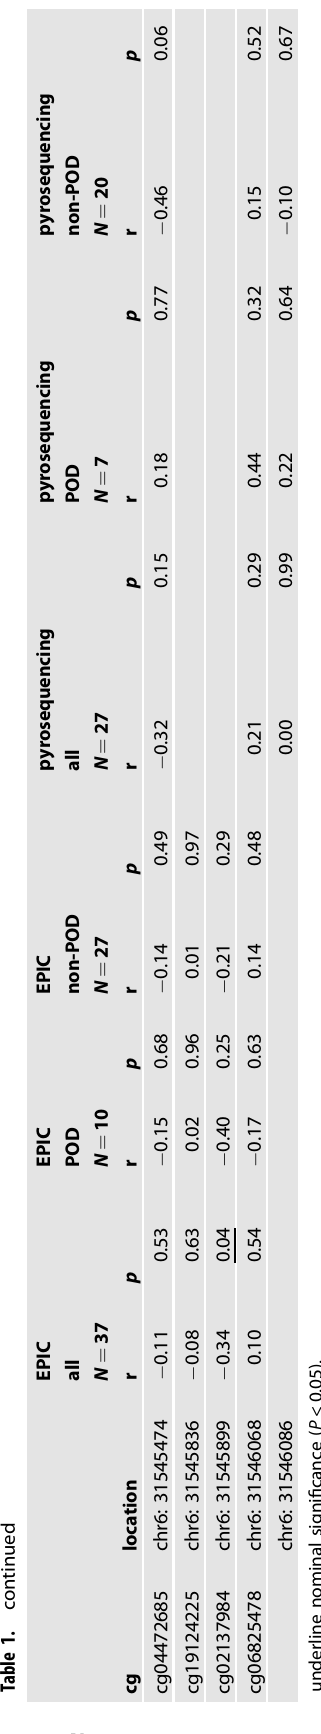
In fl ammatory methylation index (IMI) and ROC